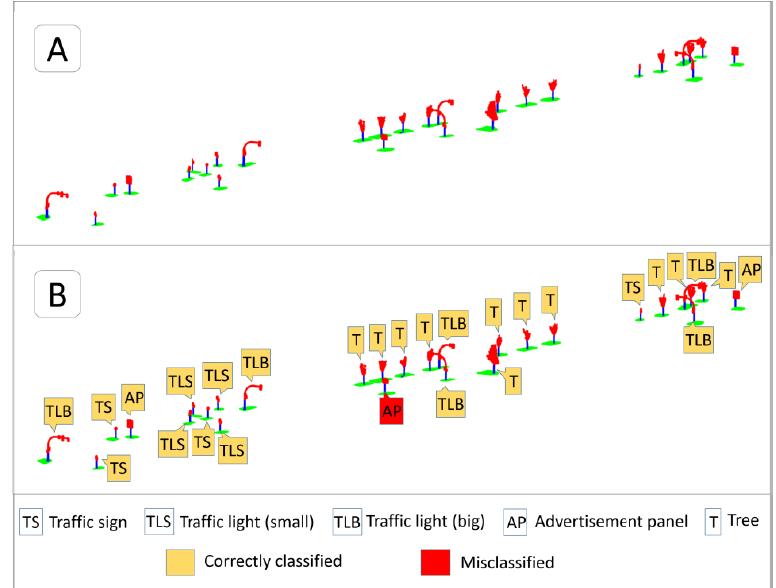
Figure 6. Pole-like object segmentation and classification in a stretch of the test street. ( A ) Poles, features attached to them, and a portion of ground around each pole following the same color schema as in Figure 5; ( B ) Classification and labeling of the objects on segmented poles using SVM.